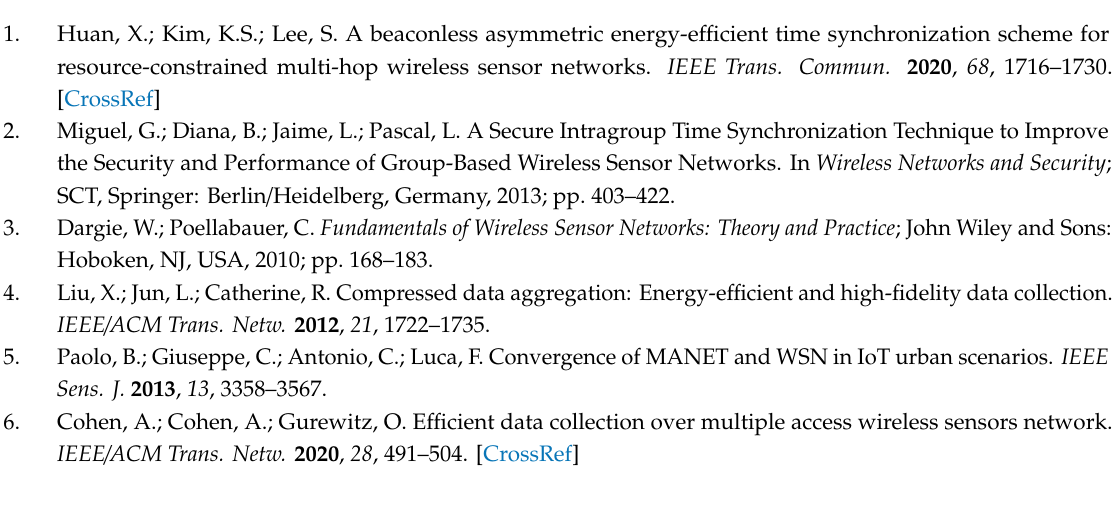
Figure 12. Comparison of synchronization in different topologies.